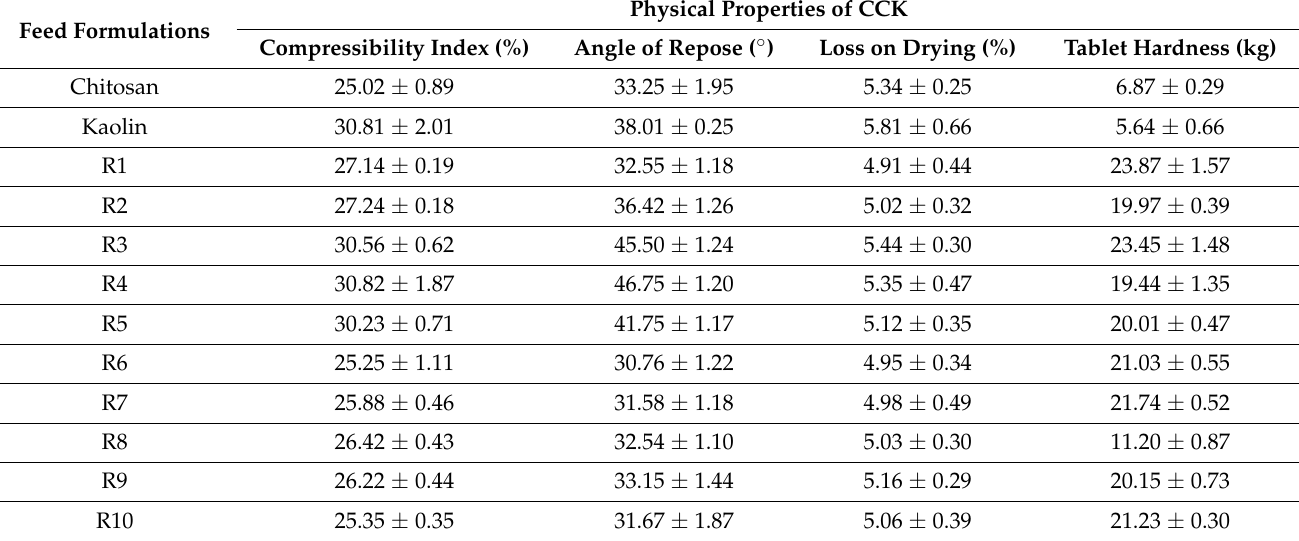
Table 2. Physical properties of the developed co-processed chitosan–kaolin.